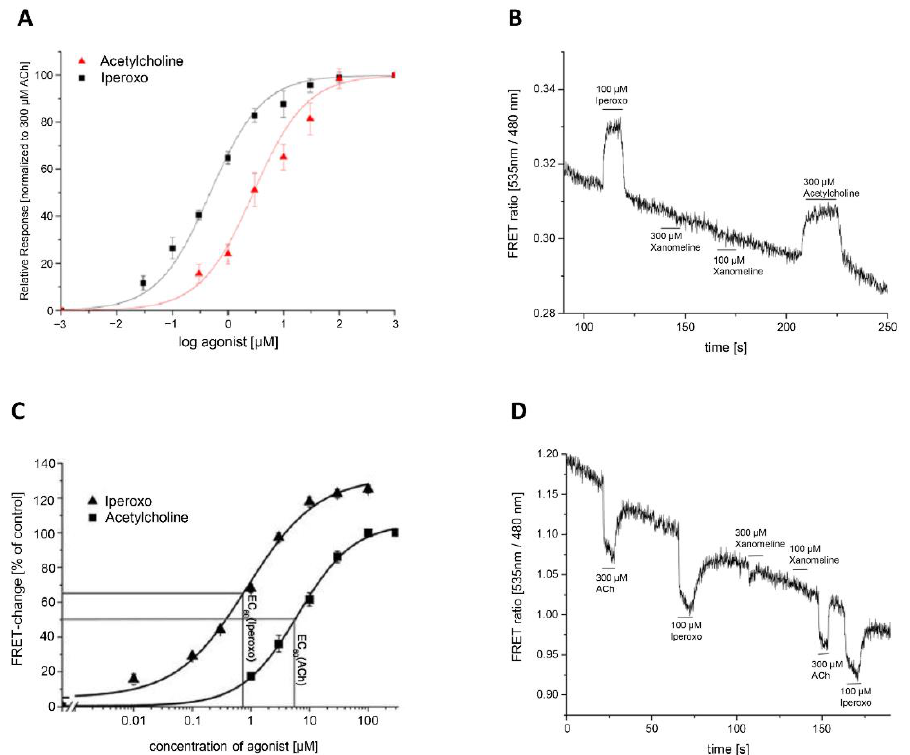
Figure 3. Ligand characterization at the M 1 and M 2 muscarinic receptor sensors. ( A ) Concentration response curves of ACh ( 1 ) and Iperoxo ( 2 ) as calculated from FRET experiments using the M 1 receptor sensor. Each ligand concentration is represented by an average value of at least 10 cells; ( B ) a FRET recording of the M 1 receptor sensor stably expressed in HEK293 cells is illustrated. Additionally, 100 micromolar Iperoxo ( 2 ), 300 micromolar ACh ( 1 ), and 100 and 300 micromolar Xanomeline ( 10 ), were applied as indicated at the appropriate time points by black bars above or below the recorded signal. ( C ) Concentration response curves of ACh ( 1 ) and Iperoxo ( 2 ) as calculated from FRET experiments using the M 2 receptor sensor. Each ligand concentration is represented by the average value of at least 10 cells; ( D ) a FRET recording of the M 2 receptor sensor stably expressed in HEK293 cells is illustrated. Additionally, 300 micromolar ACh ( 1 ), 100 micromolar Iperoxo ( 2 ), and 100 and 300 micromolar Xanomeline ( 10 ), were applied as indicated at the appropriate time points by black bars below or above the recorded